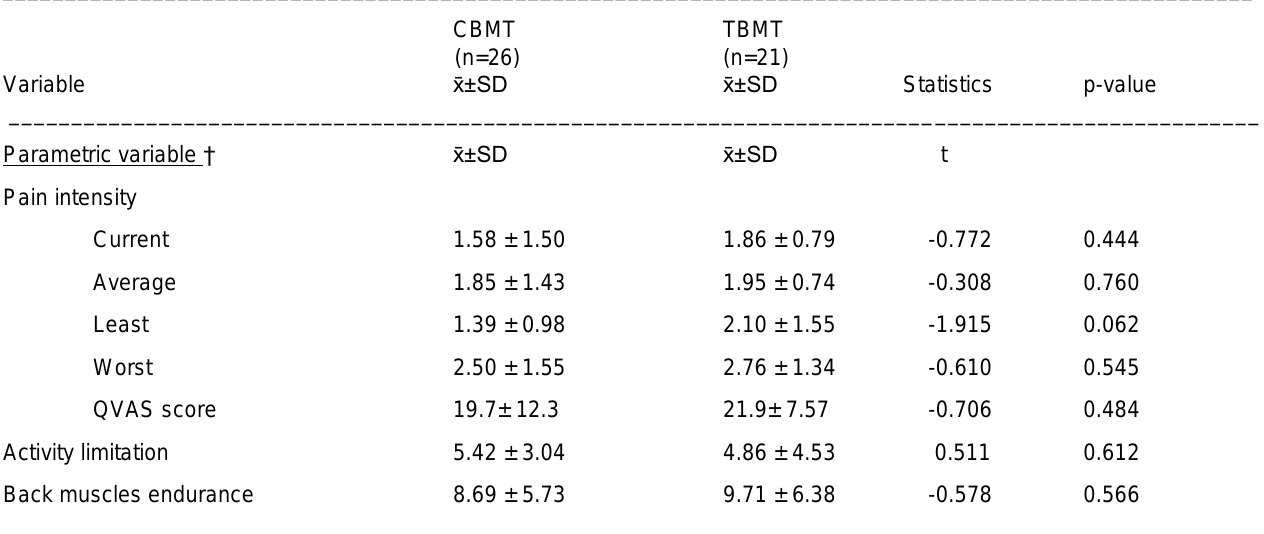
Table 6. Comparison of Participants’ Treatment Outcomes (Mean Change) for the Continuous Variables at Week 4 of